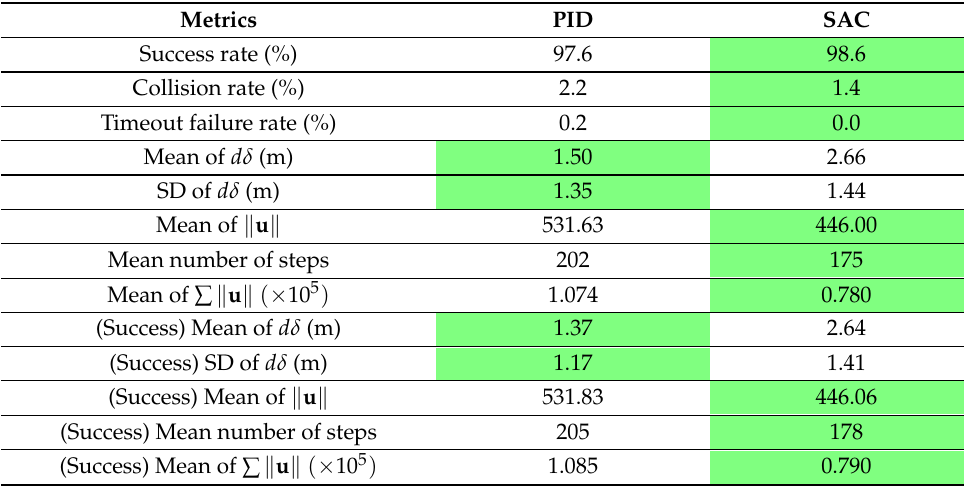
Table 2. Testing phase of a model based on the initial state vector, trained on 1300 episodes. For each metric, the controller with the best score is highlighted in